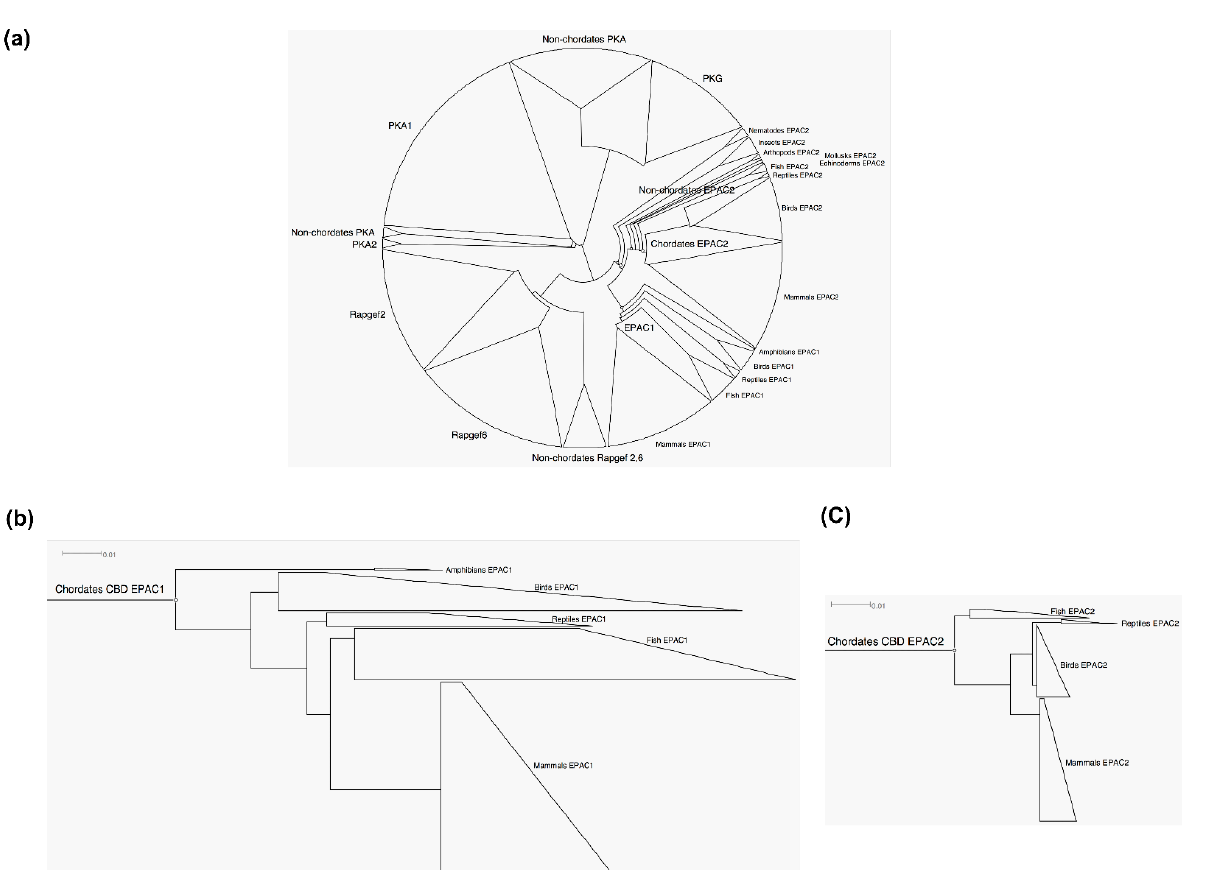
Figure 3. Phylogenetic analyses of the CBD of PKA, PKG and EPAC1, EPAC2, RAPGEF 2 and 6. ( a ) Unrooted cladogram of CBD of PKA, PKG and EPAC1, EPAC2, RAPGEF 2 and 6. ( b ) Rooted phylogram of chordate CBD of EPAC1. ( c ) Rooted phylogram of chordate EPAC2. Scale bars: 0.01 represents 1 aa substitution per 100.